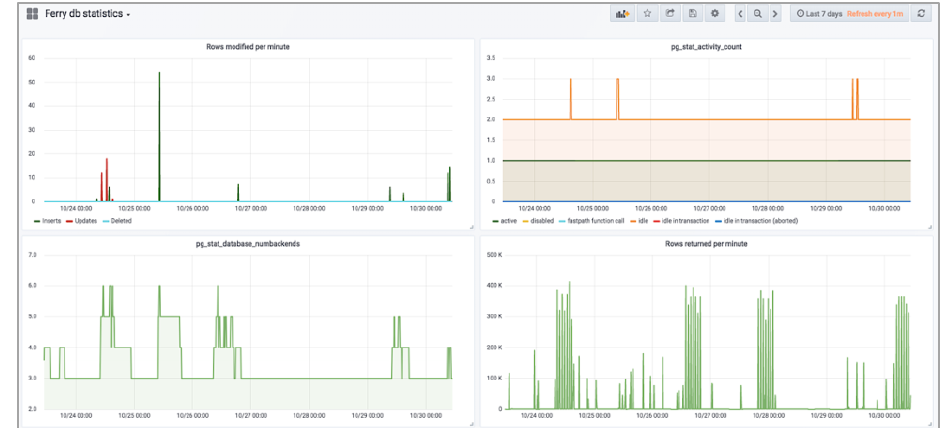
Fig.4. Monitoring database performance using Grafana/Graphite